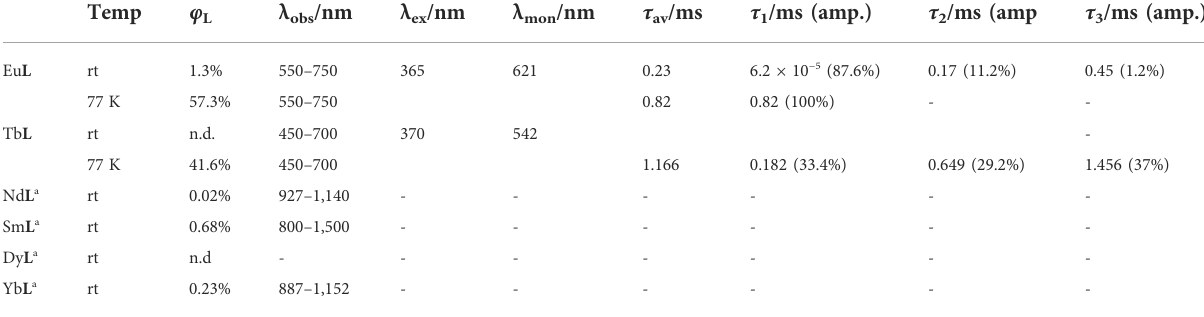
TABLE 2 Luminescence QY and lifetimes of a series of LnL